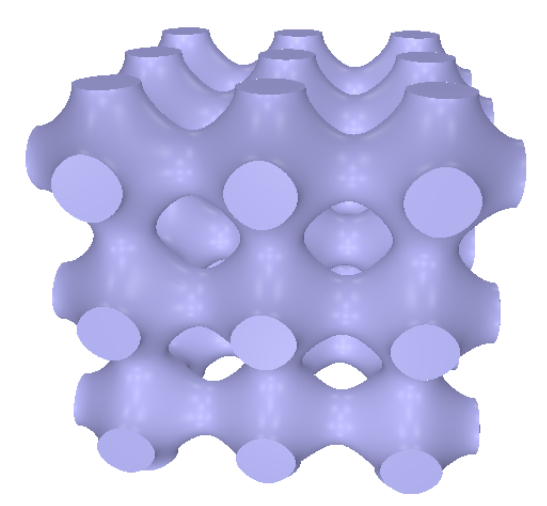
Figure 10. Three-dimensional rendering of the P-Schwarz lattice for t = 0.1 (Equation (16)). Three periods are represented along the three